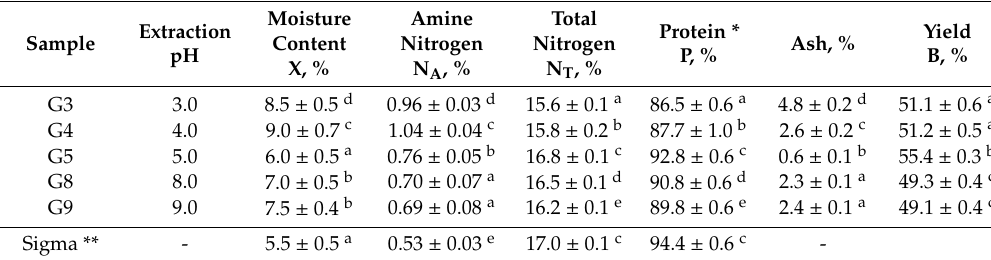
Table 1. Chemical composition of gelatin samples obtained from cod skin at di ff erent pH values of